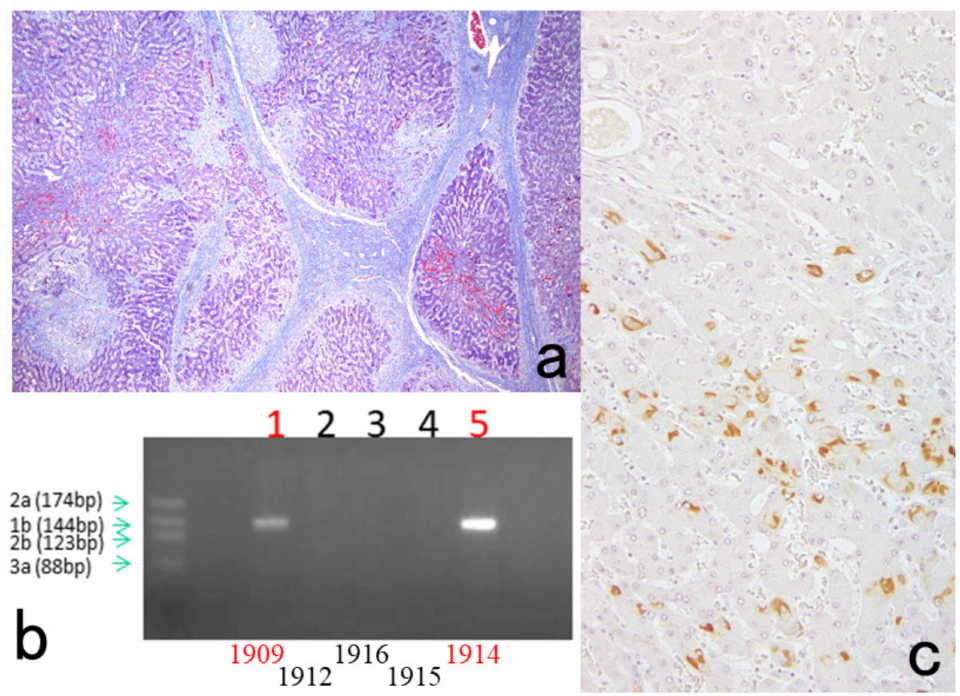
Figure 7. Demonstration of HBs antigen and HCV genome in archival specimens of liver cirrhosis fixed for up to 110 years. ( a ): Azan stain, ( b ): Nested reverse transcription-PCR for detecting the C-region of the HCV genome, ( c ); Immunostaining for HBs antigen. HCV-RNA subtype 1b was detected with nested RT-PCR (lane 1), and the same cirrhotic specimen in 1909 was immunoreactive for HBs antigen. Double infection of HBV and HCV was proven. Another specimen in 1914 (lane 5) was also double-positive for HCV, 1b-type, and HBs